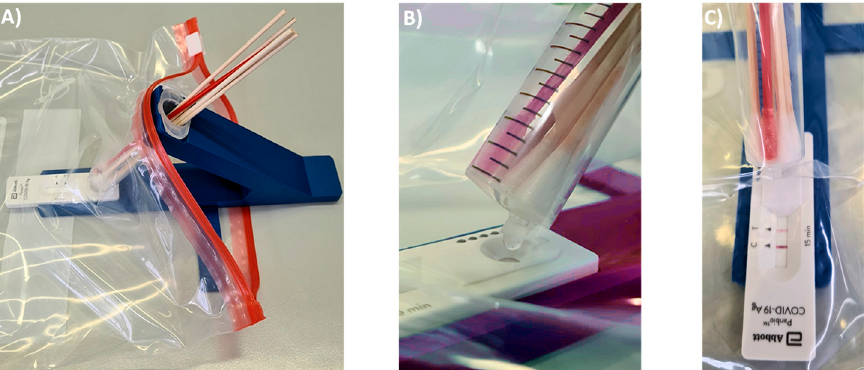
Figure 3. Photographs of testing with the device in a polyethylene bag with zip lock for encapsulation after loading. ( A ) Device loaded with five 100 µL flocked cotton swabs holding specimen and one positive control swab (red). ( B ) Close-up showing elution of the extract after thoroughly mixing for 3 min. Three drops are required to elute 100 µL from the pruned syringe, corresponding to 5 drops from the original Abbott extraction container. ( C ) Result of a test, viewed through the encapsulating bag after 15 min.